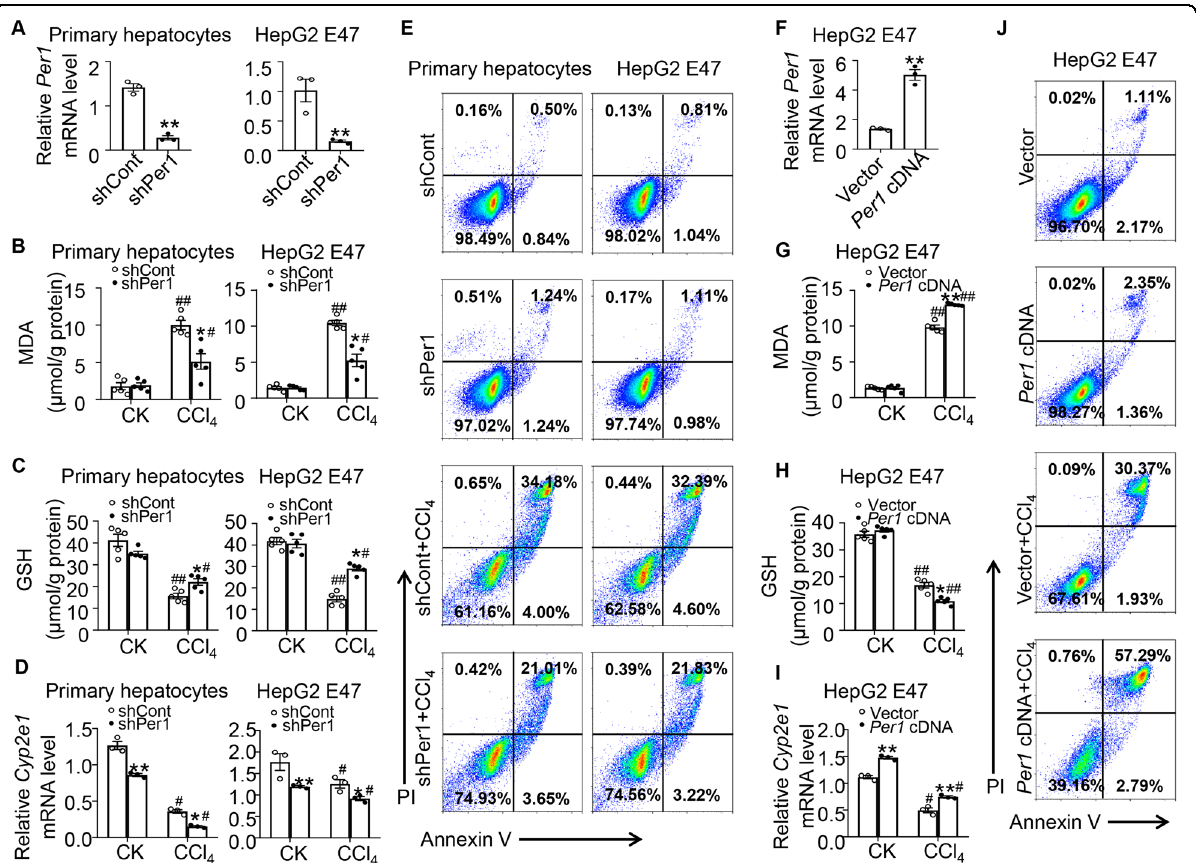
Fig. 6 Per1 mediated the regulation of Cyp2e1 expression in vitro. A Knockdown of Per1 was veri fi ed by real-time PCR after infection with shPer1 or shRNA control (shCont) in primary cells and HepG2 E47 cells. Cells were harvested after treatment with 0.5% CCl 4 for 24 h. Levels of B MDA and C GSH in cell lysates were determined. D Cyp2e1 expression was measured by real-time PCR. E Representative images of fl ow cytometry analysis of apoptosis by annexin V/PI staining in primary cells and HepG2 E47 cells infected with shPer1 or shCont. CK: control. Data were shown as means ± S.E.M. N = 3 – 5 independent biological replicates per group. * indicates P value <0.05, ** indicates P value <0.01, shPer1 group versus shCont group; # indicates P value <0.05, ## indicates P value < 0.01, CCl 4 group versus control group. HepG2 cells were transfected with Per1 cDNA or vector as control. F Real-time PCR was used to analyze changes in gene expression of Per1 . Levels of G MDA and H GSH in cell lysates were determined. I Cyp2e1 expression was measured by real-time PCR. J Representative fl ow pro fi le of annexin V/PI staining. CK: control. Data were shown as means ± S. E.M. N = 3 – 5 independent biological replicates per group. * indicates P value <0.05, ** indicates P value <0.01, Per1 cDNA group versus vector group; # indicates P value <0.05, ## indicates P value <0.01, CCl 4 group versus control group. Data represent cumulative results from three